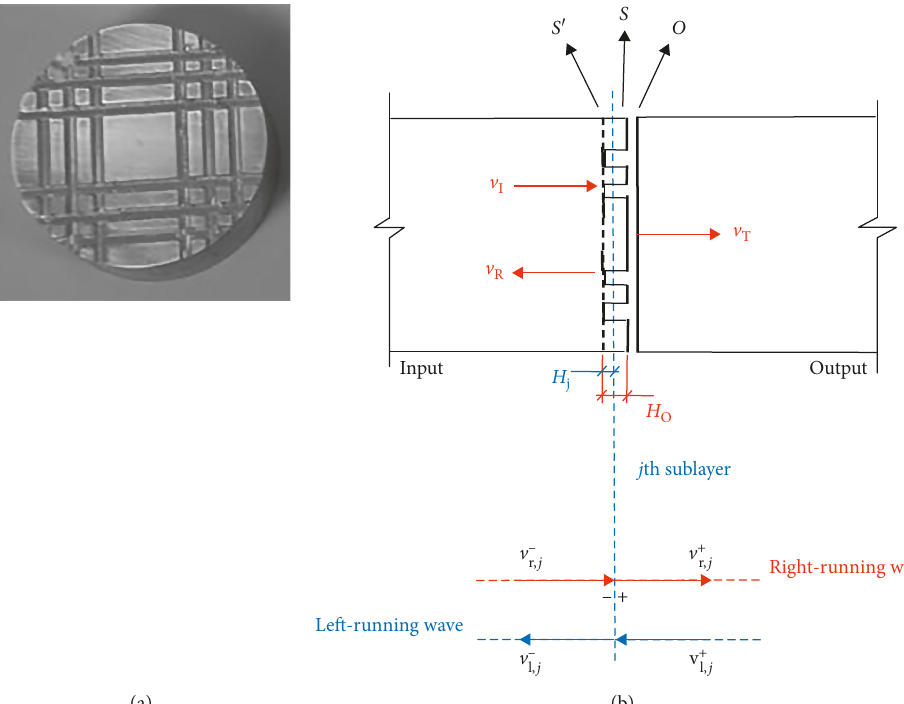
Figure 1: P-wave propagates through a rough joint. (a) An artificial rough surface of a specimen in the modified SHPB tests. (b) P-wave separation when propagating across the